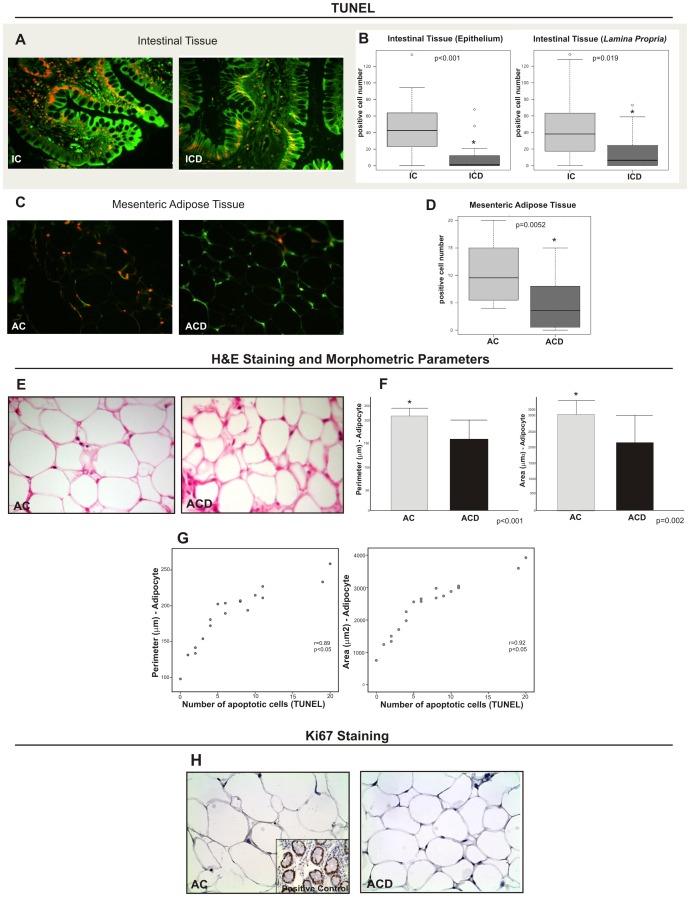
TUNEL assay shows different patterns in the intestinal mucosa (ICD) and in the mesenteric adipose tissue (MAT) of Crohn’s disease (ACD), compared to the respective control biopsy samples (IC and AC).(A) Enterocyte and lamina propria cell apoptosis are shown by immunofluorescence staining (overlay image); TUNEL+ cells are showed in orange (co-labeled by PI and FITC). Low numbers of TUNEL+ enterocytes and lamina propria cells were detected in the ICD group compared to IC. (C) Adipocyte apoptosis, shown by immunofluorescence staining (overlay image); TUNEL+ cells are showed in orange (co-labeled by PI and FITC). Low numbers of TUNEL+ adipocytes were detected in the ACD group compared to AC. Note the high density of TUNEL+ adipocytes, in orange, in the control (AC). Images were obtained using a 40x objective. (B) and (D) Quantitative analysis of TUNEL staining in the ICD and ACD groups, compared to the respective controls (IC and AC). The graphs of intestinal tissue show the quantitative analysis for the epithelium and lamina propria TUNEL staining, separately. For ICD, n = 10; for ACD, n = 10; for IC, n = 8; and, for AC, n = 8, *p<0.05 vs control. (E) Representative hematoxylin-eosin (H&E) staining of fixed paraffin-embedded MAT from AC and ACD groups shows lower area and perimeter of the adipocytes in the ACD group, compared to the control (AC). Images were obtained using a 40x objective. (F) Quantitative morphometric histological analysis in the mesenteric adipose tissue (MAT) of Crohn’s disease (ACD), compared to the respective control group (AC). The graphs show the decreased perimeter (µm) and area (µm2) of the adipocytes from the MAT of Crohn’s disease, compared to the control biopsy samples. For ACD, n = 10; for AC, n = 8, *p<0.05 vs control. (G) The graphs dispersion show a significant correlation between the perimeter (µm) and the number of apoptotic cells (TUNEL+), (r = 0.89, p<0.05) and also between the area (µm2) and the number of apoptotic cells (TUNEL+), (r = 0.92, p<0.05). (H) Immunohistochemical staining of Ki67 in the mesenteric adipose tissue (MAT) of the Crohn’s disease group (ACD), compared to the control biopsy samples (AC); no evidence of proliferation were found in all samples (ACD, n = 10; AC, n = 8). Images were obtained using a 40x objective. The positive control was from tissue section of intestinal mucosa.